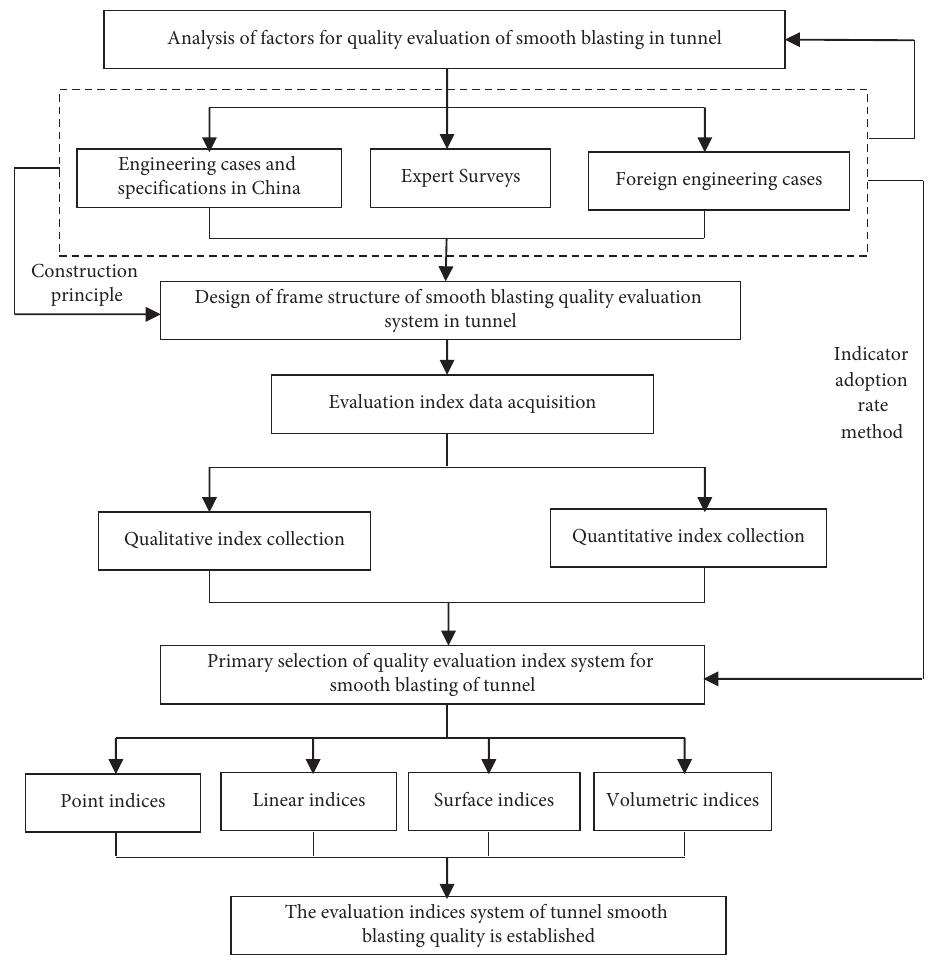
Figure 8: Framework of the multiple indices